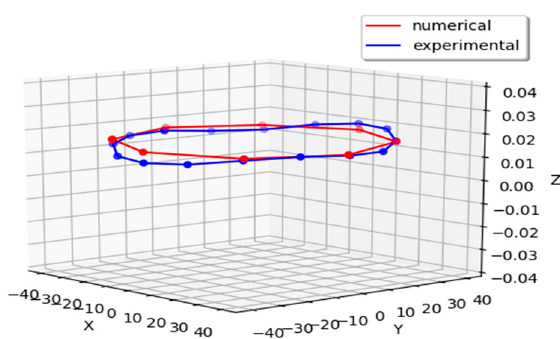
Figure 10. Deformations obtained by the numerical simulation. Figure 9. Average values of surface flatness calculated from experimental measurements.